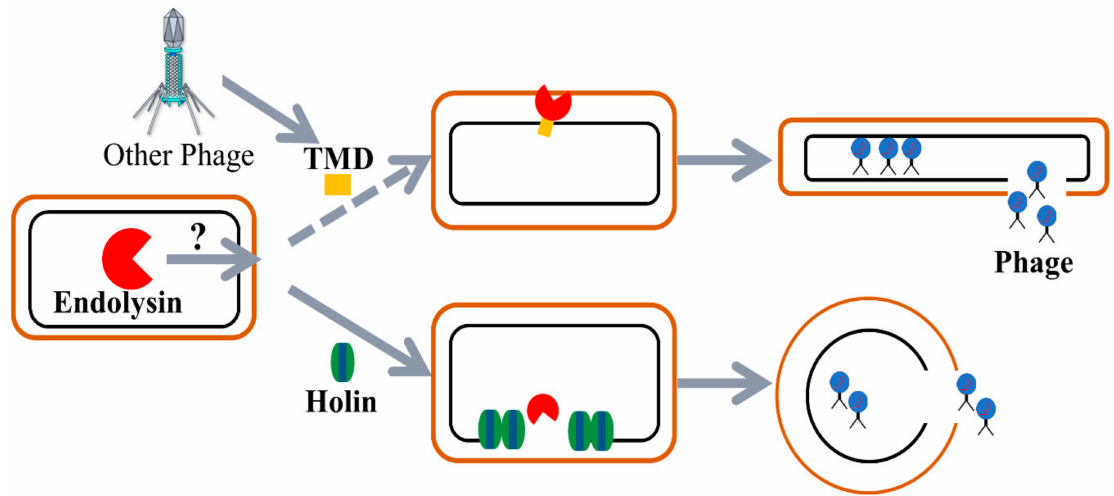
Figure 10. Transport of the endolysin mediated by holin or the TMD, which can result in different morphological changes of the host